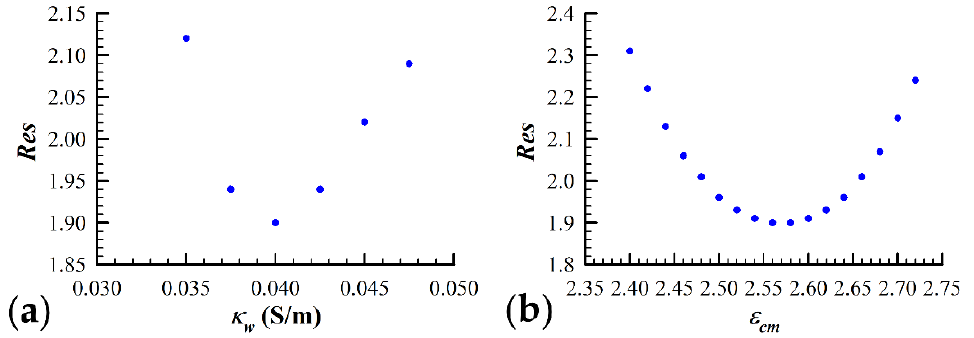
Figure 2. Validation of the three-shell model applicability. The fitting procedure, as described in Section 2.3.3, was performed by iterating a number of key model parameters to find the global minimum fit of the spherical three-shell model to the measured data. ( a ) The conductivity of the cell wall, κ w , was iterated in increments of 0.0025 S/m until the Res values obtained for a given data set were greater than 10% of the minimum value obtained. ( b ) Using the value for κ w which resulted in the simulation of the measured data with the lowest fitting residual ( κ w = 0.04 S/m), the iteration process was repeated by changing the permittivity of the cell membrane ( ε cm ) in increments of 0.02. As it can be seen in the figure, there exists a unique set of parameters that give the “best fit” to the measured data.